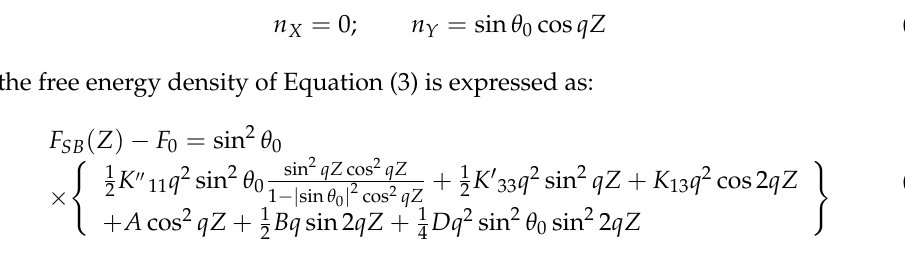
Figure 3. Phase diagrams in the space of the dimensionless parameters ρ (= K (cid:48) 33 / K 22 ) showing the boundaries of states with constant projection of the uniaxial nematic director n along the modulation direction Z. For N U the projection is maximal, n · Z = 1; for N T it is minimal, n · Z = 0 and intermediate for the N TB , n · Z = cos θ 0 . The values of sin 2 θ 0 and of the scaled wavenumber k / k 0 are indicated on the constant-value contours of ( a , b )